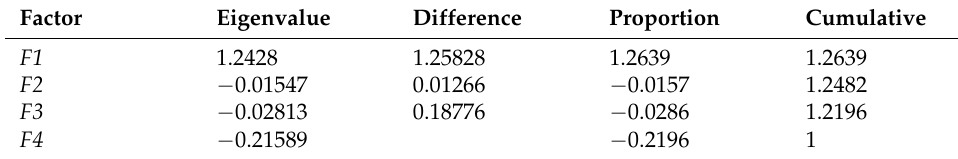
Table 4. Factor Analysis.